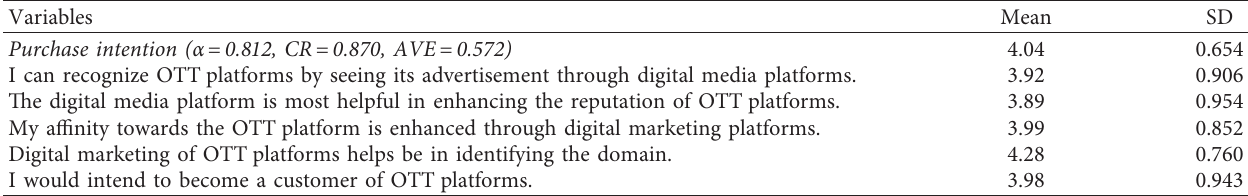
Table 7: Consumer purchase intention of OTT.